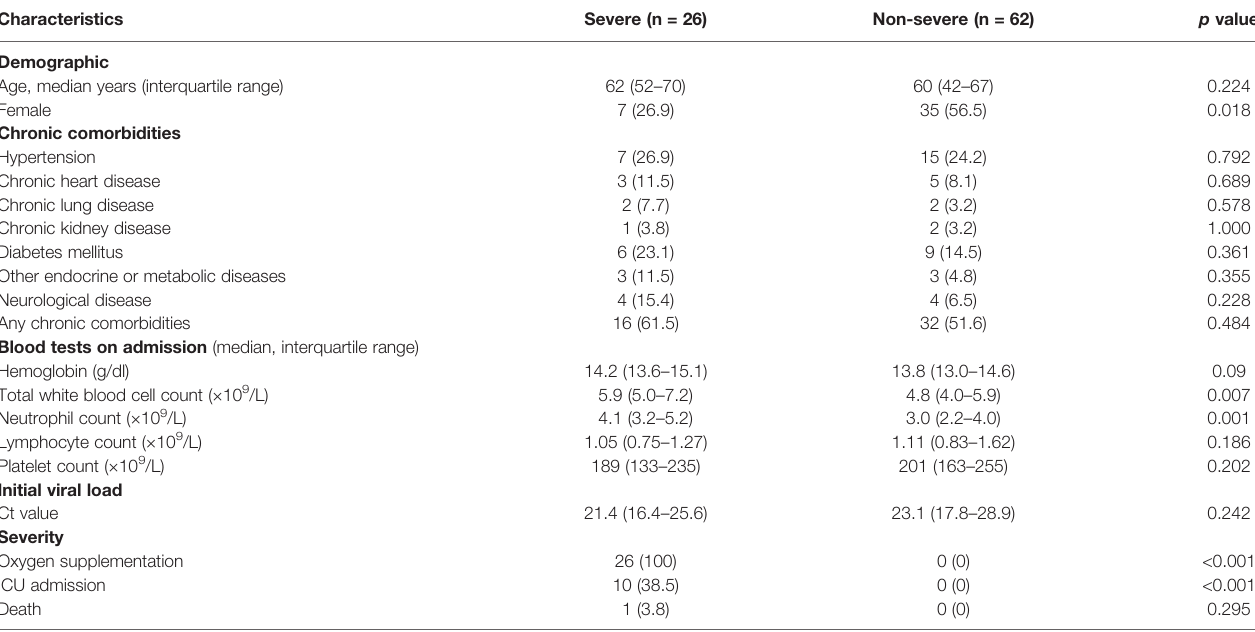
TABLE 1 | Brief table for patient information description of 88 recruited acute patients.